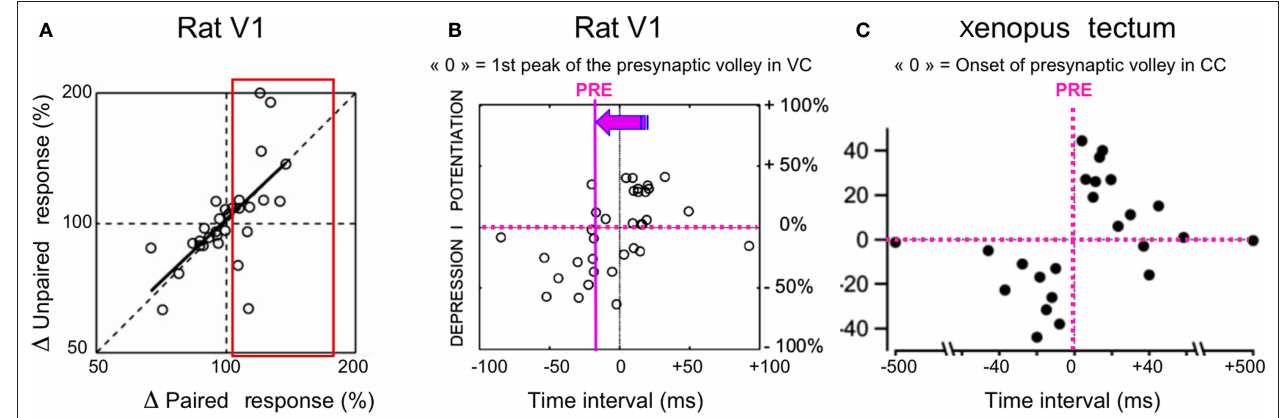
Figure 9 | re-examination of in vivo STDP. (A) Rat visual cortex, taken from Figure 4E in Meliza and Dan (2006): change in unpaired RF region vs change in the paired region (log-log scale) following STDP intracellular pairings (see text for details). Each point represents an individual cell. The oblique regression line is a linear fit calculated on all cases (potentiation and depression). The red inset underlines the lack of spatial selectivity for potentiation effects, whose amplitudes are often larger for the unpaired than for the paired positions. (B) Rat visual cortex, adapted from Figure 2E in Meliza and Dan (2006): Change in amplitude of visual response at paired location as a function of pairing interval. Each symbol represents one cell. The x -axis coordinates of the original plot have been inverted in sign, to make the STDP curve comparable to that